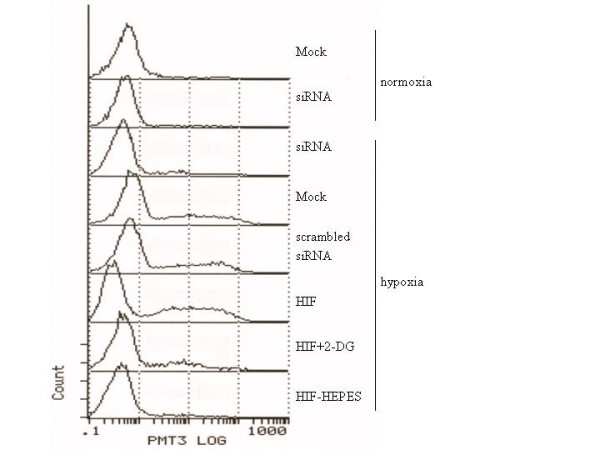
Detection of apoptosis by flow cytometry: histogram analysis. A549 cells were transfected with HIF-1α siRNA vector or HIF-1 expression plasmid. Cells were allowed to recover in regular culture medium for 20 h after transfection, then exposed to normoxic or hypoxic environment for 24 h with or without additional HEPES (25 mM) or the glycolytic inhibitor, 2-DG (5 mM) (n = 5 in each group). Cells were collected and stained with Apo2.7 monoclonal antibody (7A6). Shown are representative results from one of five independent experiments. siRNA: A549 cells transfected HIF-1α siRNA vector, Mock: mock-transfected, HIF: A549 cells transfected with HIF-1α expression plasmid, HIF+2-DG: Cells transfected with HIF-1α expression plasmid and cultured with 2-DG, HIF+HEPES: Cells transfected with HIF-1α expression plasmid and cultured with medium containing HEPES.